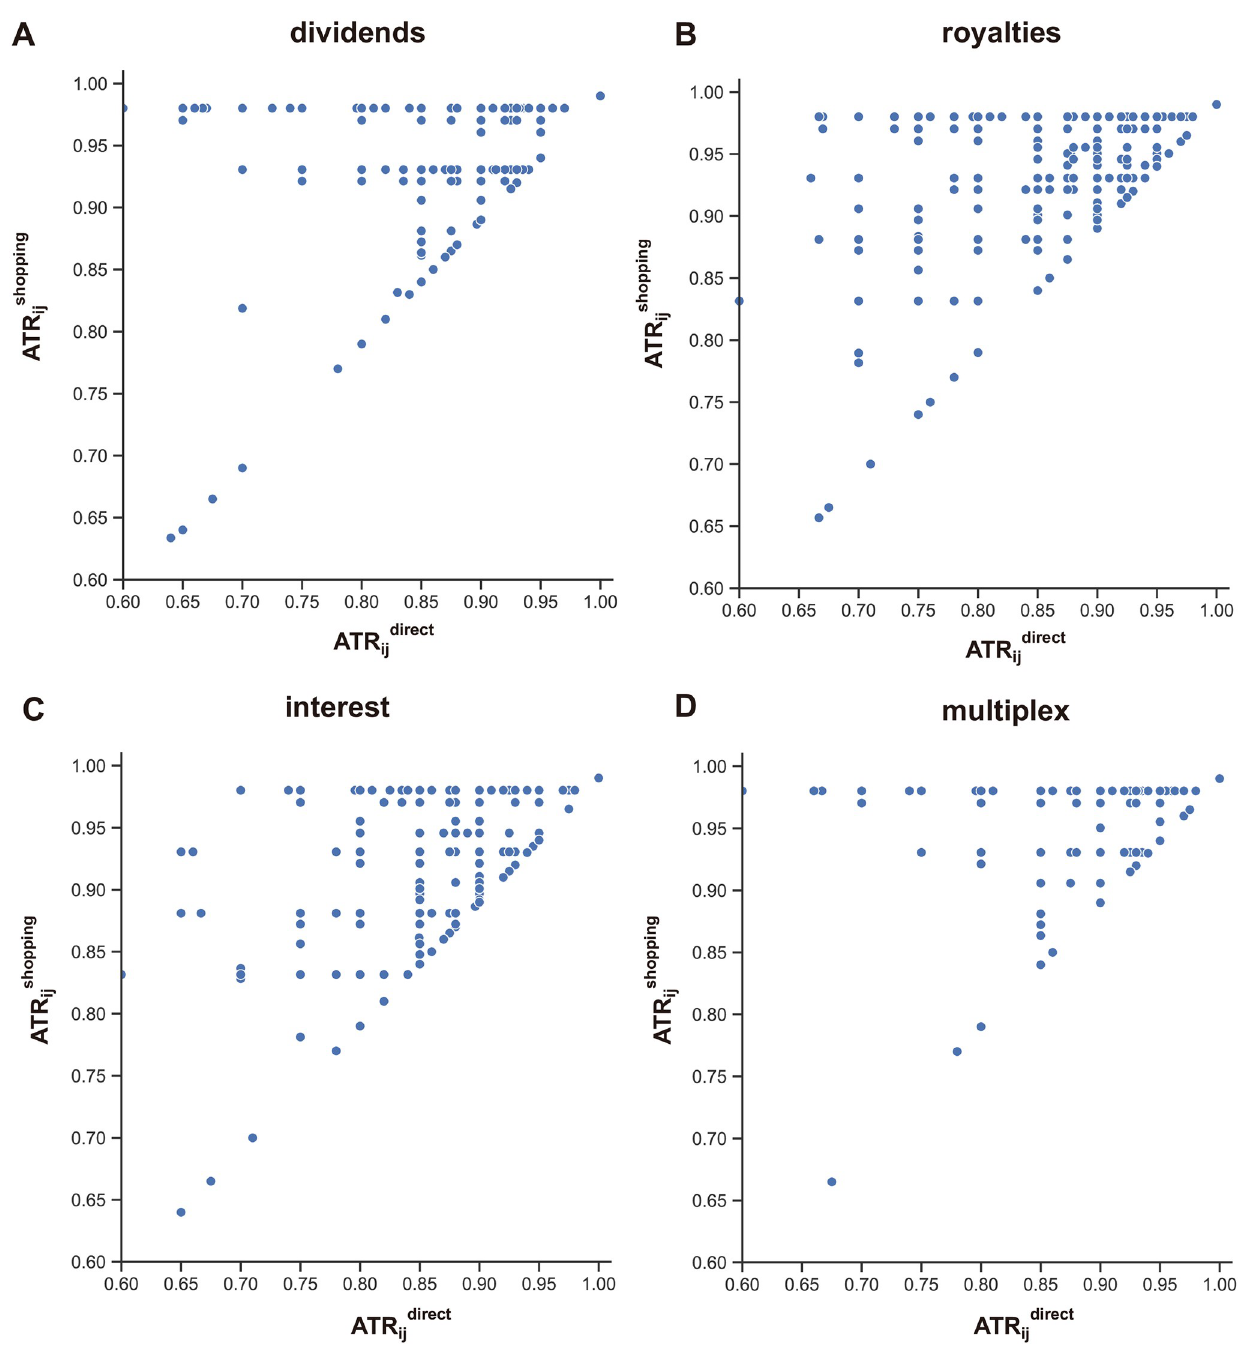
Fig 2. Comparison between direct and shopping routes for (A) dividends, (B) royalties, (C) interest, and (D) the multiplex network. The inset tables present values for the top 10 countries with the largest differences between direct and shopping routes in each layer.